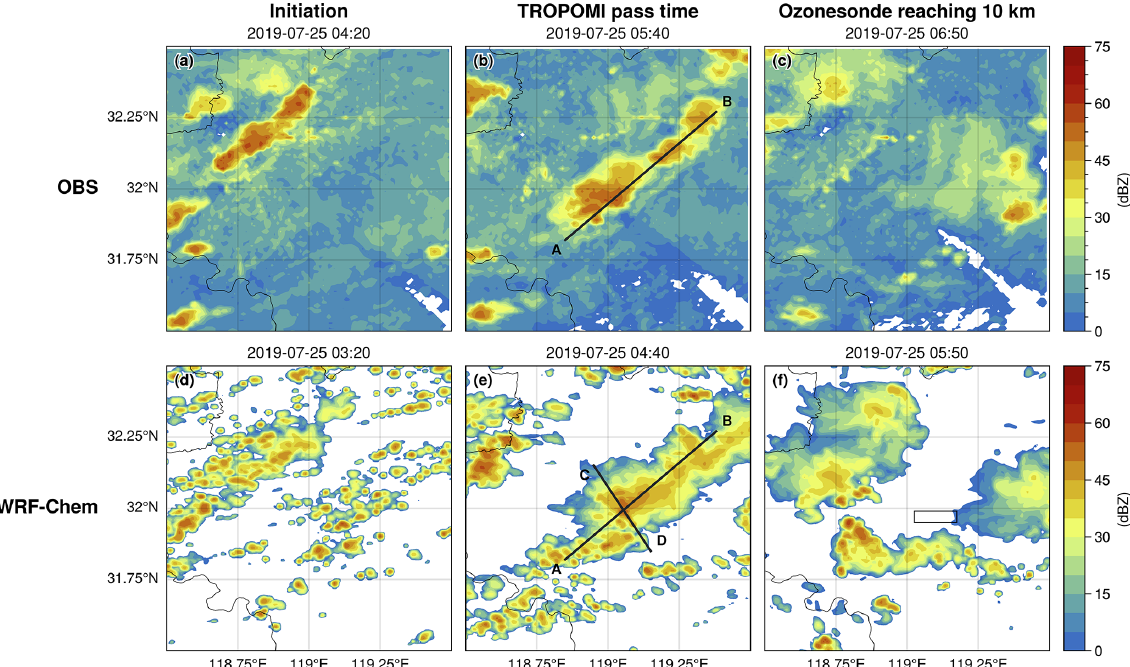
Figure 2. Observed radar composite reflectivity at (a) 04:20, (b) 05:40, and (c) 06:50UTC. (d–e) WRF-Chem simulated composite reflec- tivity 1h before the radar observation times. The A–B solid lines in (b) and (e) are cross-section lines for Fig. S3. The C–D solid line in (e) is the cross-section line for Fig. 4b. The black rectangle is the region for the comparison with